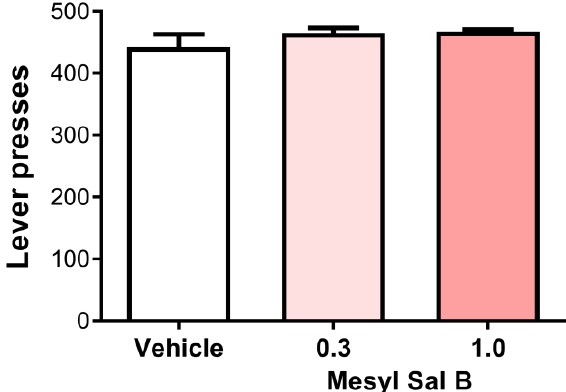
Figure 5. The effects of Mesyl Sal B on sucrose-reinforced responding. ( a ) Mesyl Sal B (0.3, 1.0 mg/kg, i.p.) has no effect on the sucrose-reinforced responding in the rat following 45 min of pretreatment compared to the vehicle controls. One-way ANOVA followed by Dunnet’s multiple comparisons test (F(2,18) = 1.113, p = 0.35). Data presented as mean ± SEM; n = 7 for each group.